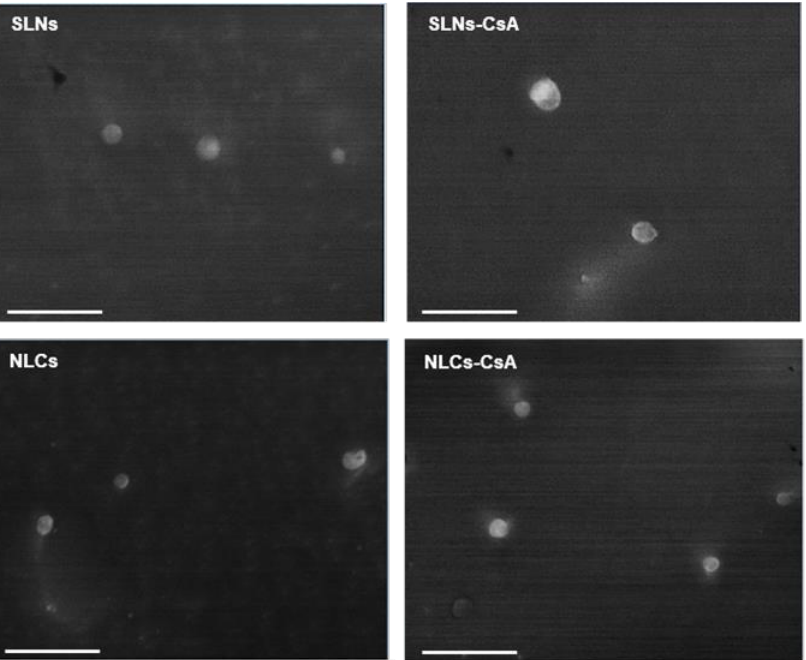
Figure 1. Morphological analysis of lipid nanoparticles for delivery of CsA. Cryo-scanning electron microscopy of SLNs, SLNs-CsA, NLCs, and NLCs-CsA. The scale bar is 1 μm.